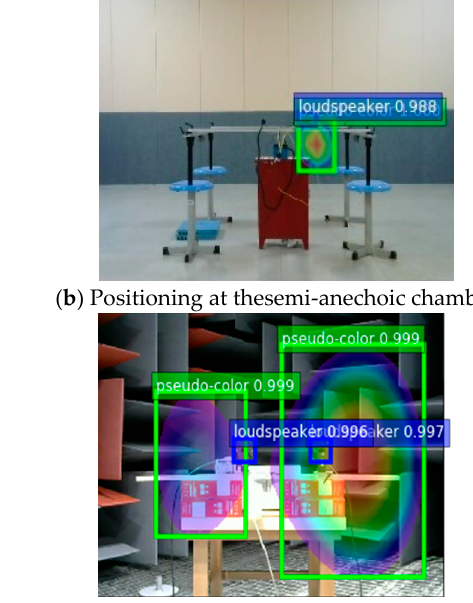
Table 4. Performance comparison of different network structures.